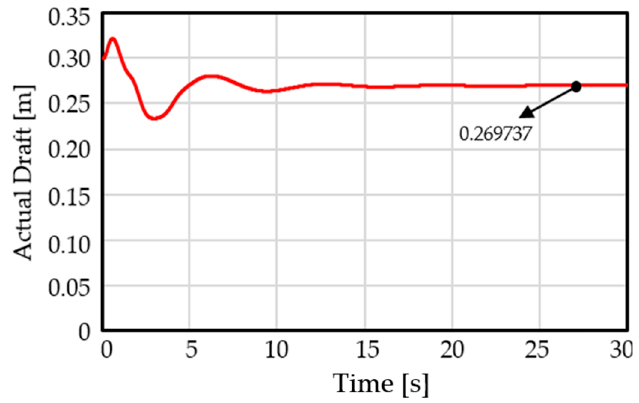
Figure 6. The actual initial draft of the damaged hull.